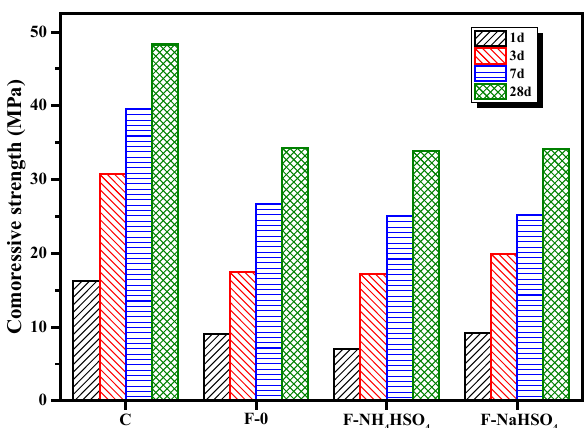
Figure 3. Effect of different sulfates on the compressive strength of fly ash cement paste.